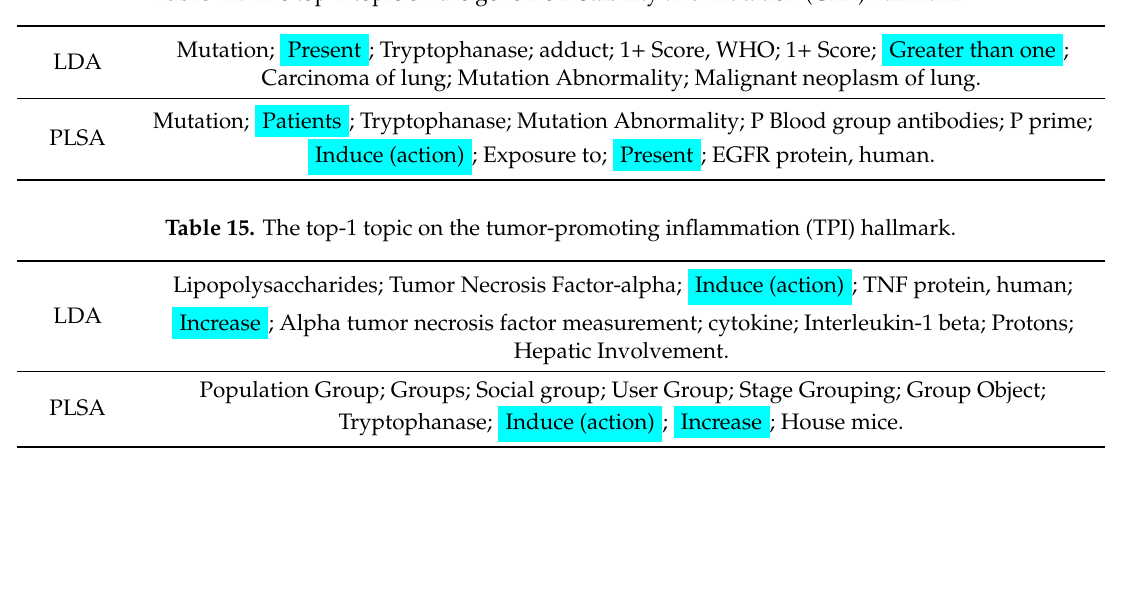
Table 14. The top-1 topic on the genome instability and mutation (GIM) hallmark.